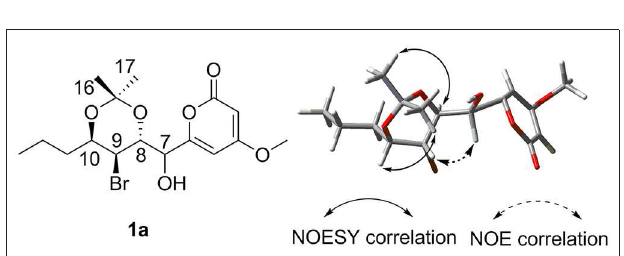
FIGURE 4 | The structure of compound 1a and its NOESY/NOE correlations.